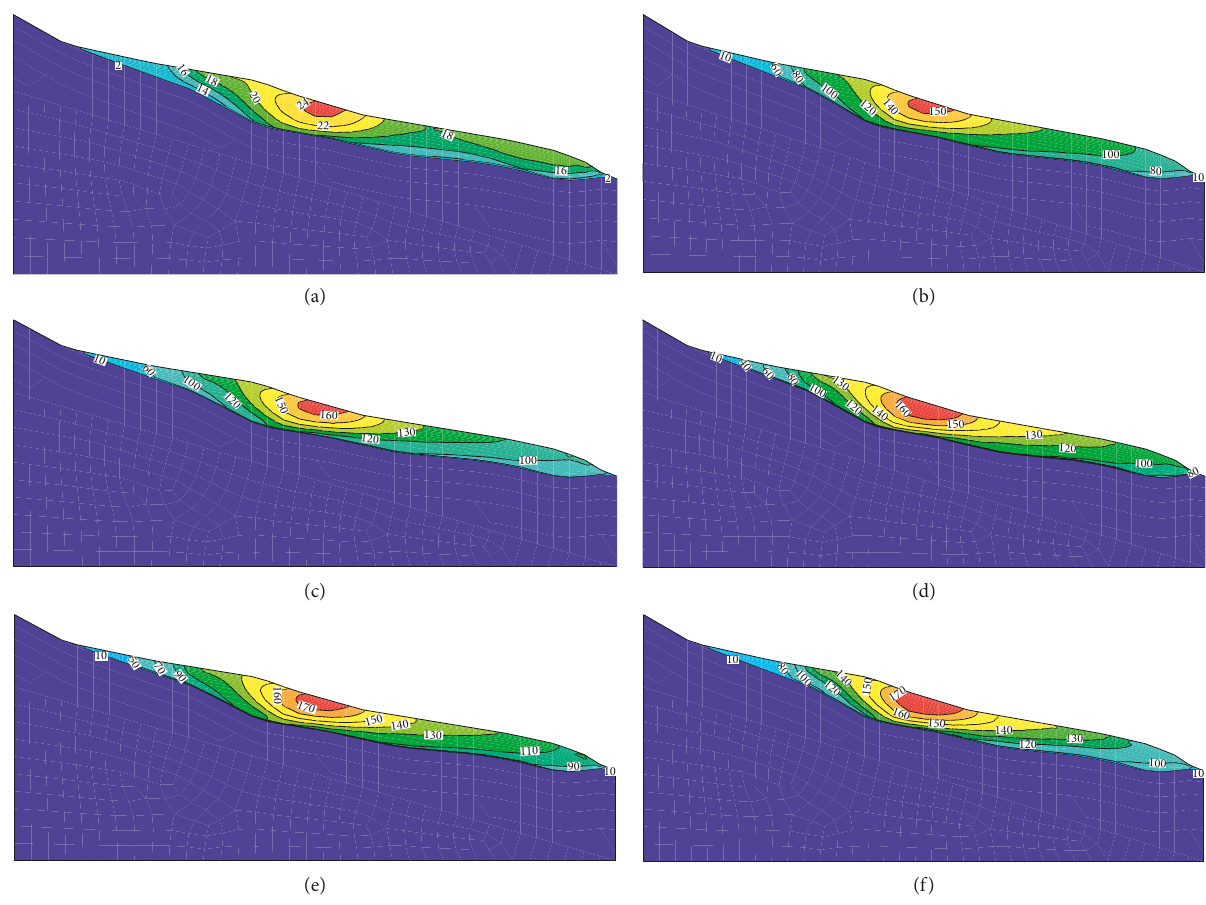
Figure 7: Horizontal displacement contour map (extended M-2K model). (a) Day 1. (b) Day 10. (c) Day 20. (d) Day 100. (e) Day 200. (f) Day 300.